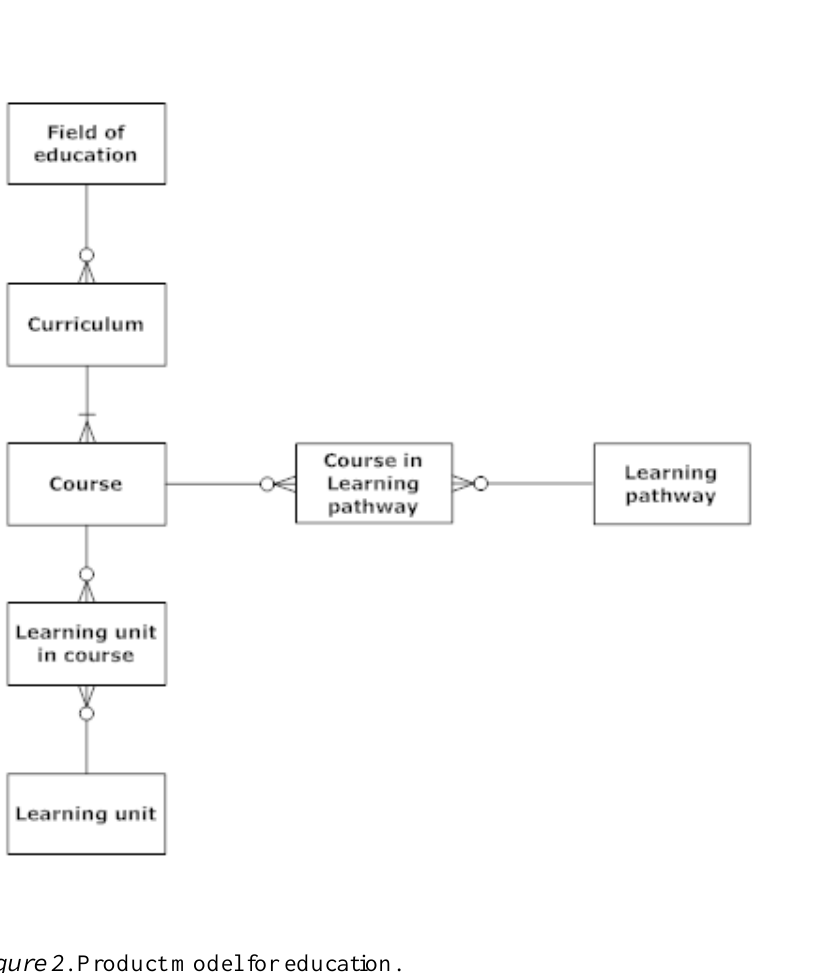
Figure 2 . Product model for